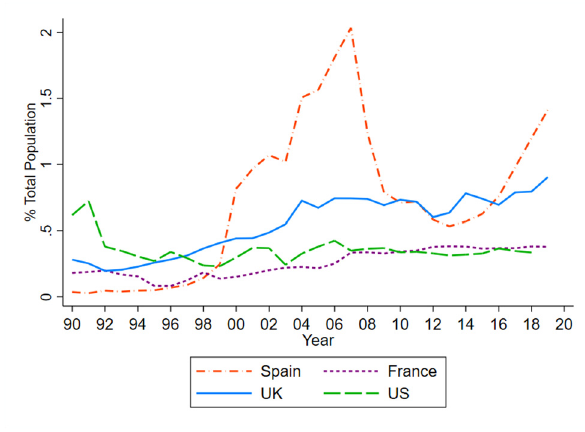
Figure 1: Immigrant in fl ows. Source: OECD international migration